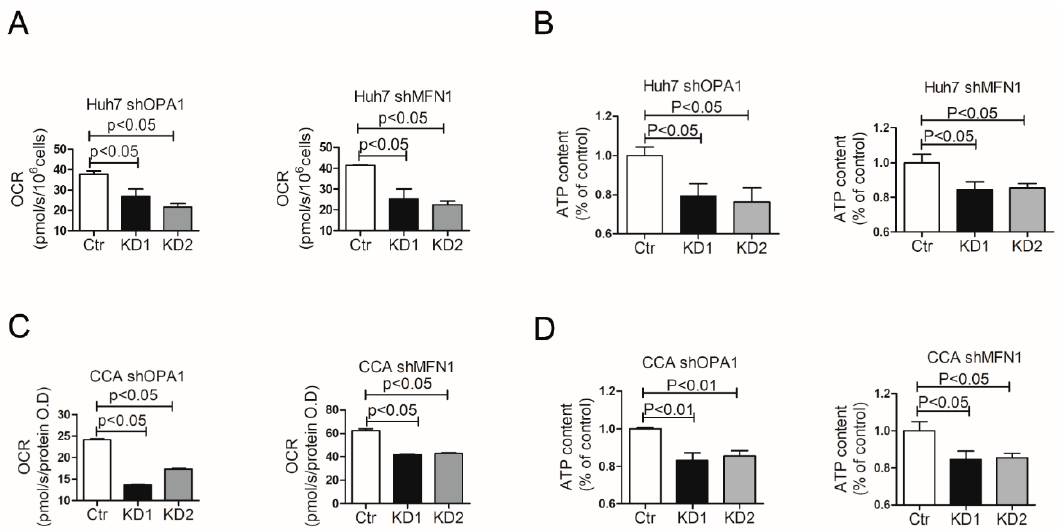
Figure 7. Inhibition of mitochondrial fusion affects Oxygen Consumption Rate and ATP production. ( A ) Real-time analysis of basal Oxygen Consumption Rate (OCR) in Huh7 shOPA1 and shMFN1 cells (n = 3). ( B ) ATP production of Huh7 cells with OPA1/MFN1 downregulation was reduced compared with control group (n = 6). ( C ) Real-time analysis of basal OCR in CCA organoids with shOPA1 and shMFN1 (n = 3). ( D ) ATP production of CCA tumor organoids with OPA1/MFN1 downregulation was reduced compared with control group (n = 6). Histograms show means ± SEM with p value derived by the Mann Whitney test.